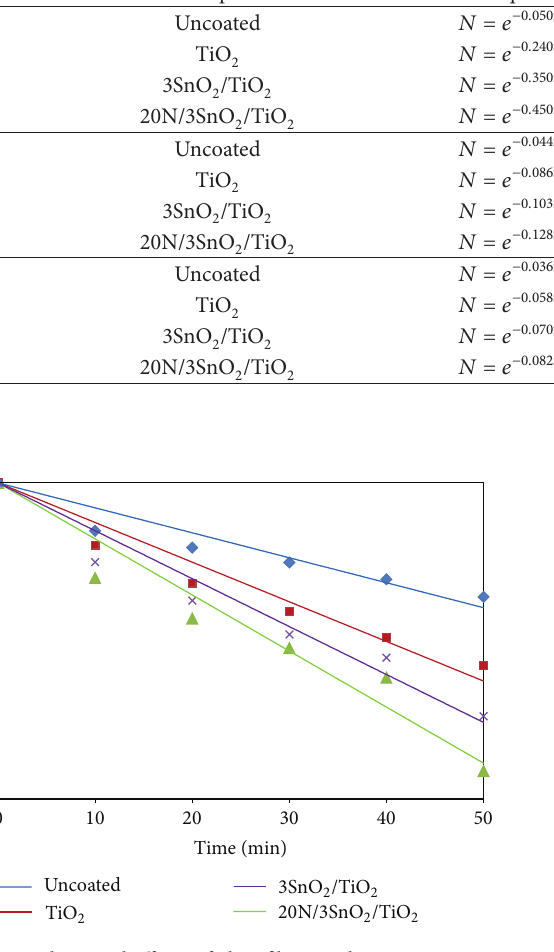
Figure 12: Antibacterial effects of glass fibers with various coatings against S. aureus under UV irradiation. Figure 13: Antibacterial effects of 20N/3SnO